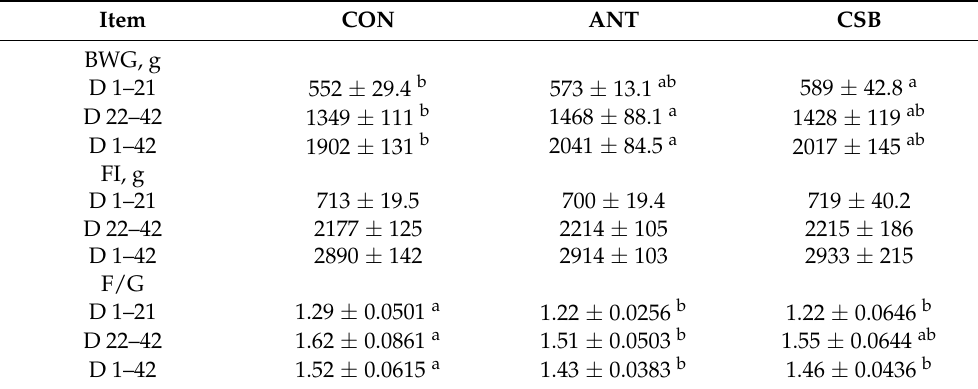
Table 1. Effects of CBS on growth performance of